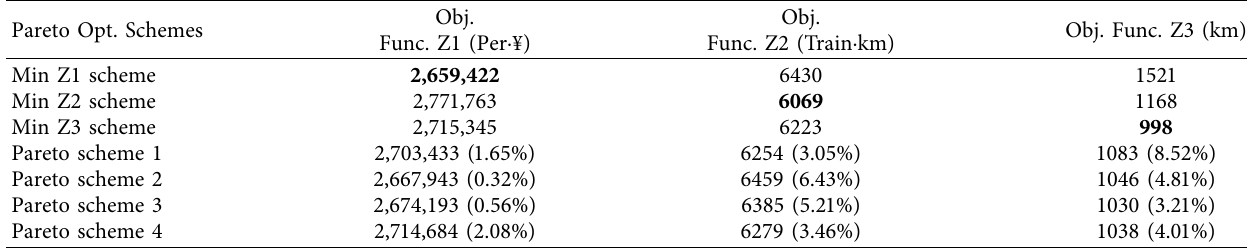
Figure 9: Pareto optimal front. Table 4: Comparison of Pareto optimal schemes for